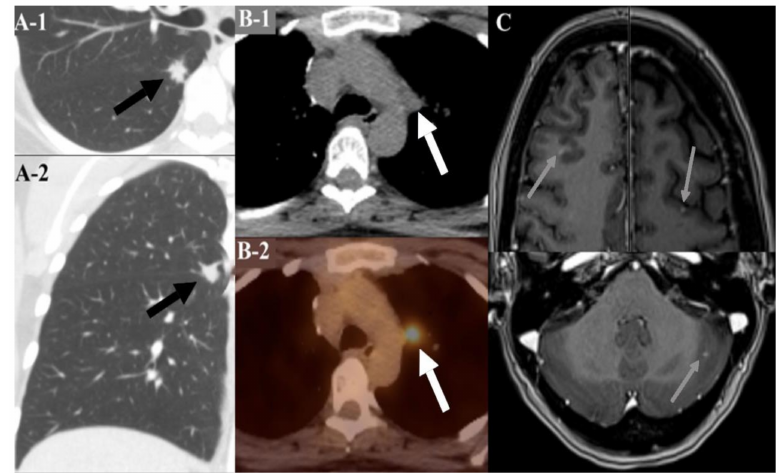
Figure 9. ( Panel A ) Routine CT chest showed a pulmonary mass with speculated irregular borders (black arrows) at the major fissure (axial in A-1 , and coronal in A-2 ). Histopathological examination showed lung adenocarcinoma. ( Panel B ) another CT chest ( B-1 ) and PET/CT image ( B-2 ) with a moderately FDG-avid aorto-pulmonary window lymph node (white arrows) with SUV = 6.3. A further work-up demonstrated the metastatic lesions seen on the brain MRI (gray arrows in panel C